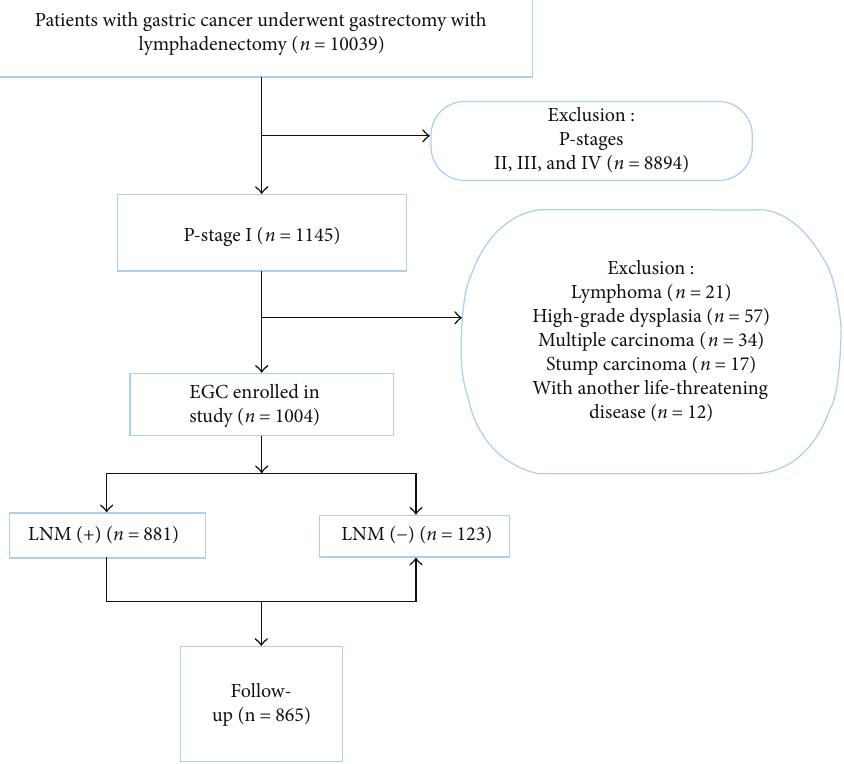
Figure 1: Flow diagram showing the study design and population. EGC: early gastric cancer; LNM: lymph node